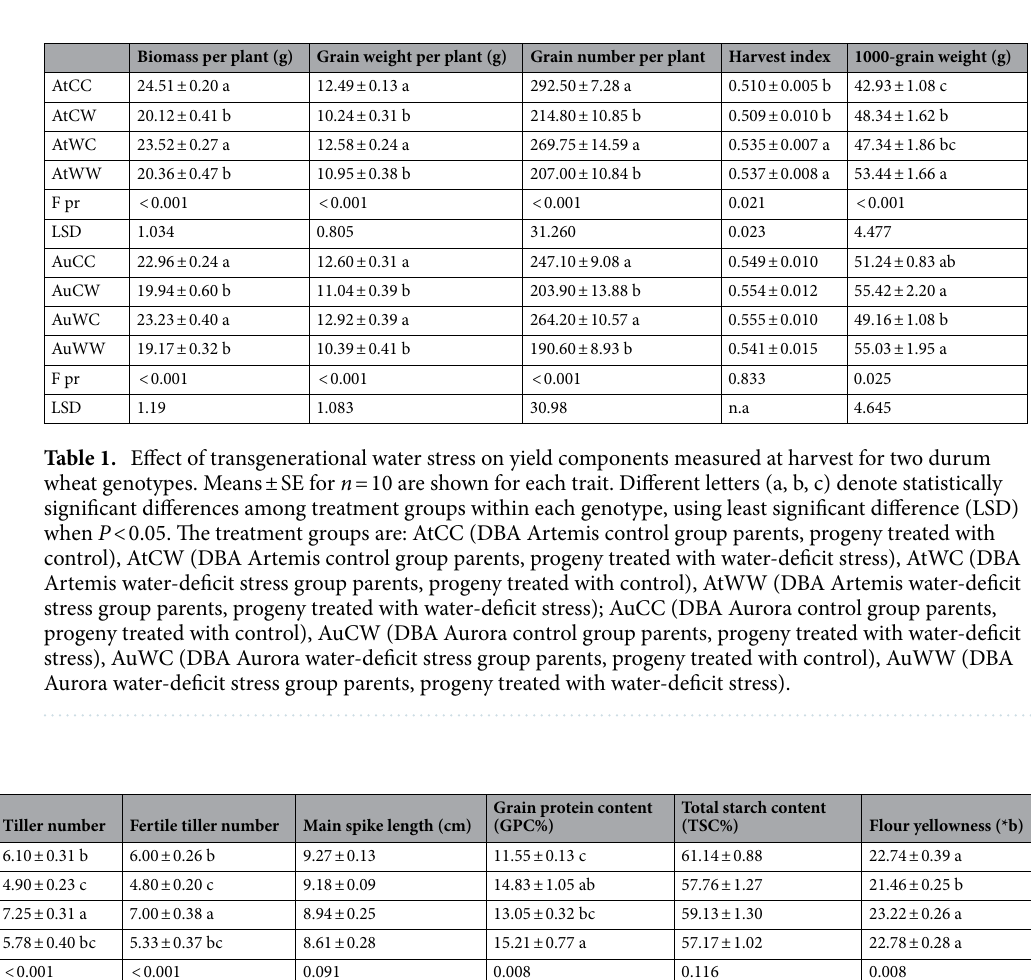
filtering. From the eight sRNA libraries, a total of 1739 MIR-miRNA entries were identified (Supplementary Table S4), considering both different MIR gene origins and different mature miRNA products. Of these, 965 were conserved miRNAs from 52 MIR families registered in the miRBase, and 774 were novel miRNAs (unique to T. turgidum ). Venn diagrams (Supplementary Fig. S1a) illustrate the distribution of miRNA numbers between different biological groups. The biological group with the highest number of unique miRNAs was AtCW, in